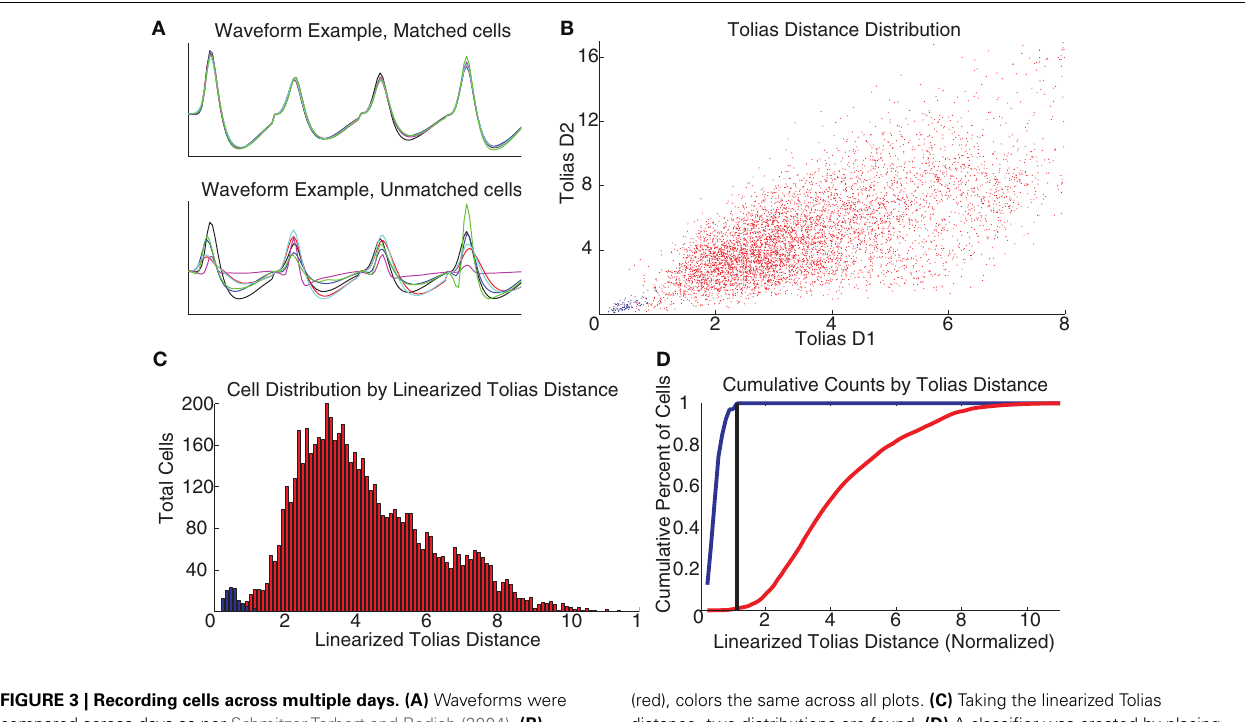
(red), colors the same across all plots. (C) Taking the linearized Tolias distance, two distributions are found. (D) A classifier was created by placing a decision threshold at the linearized Tolias distance to minimize Type I and Type II